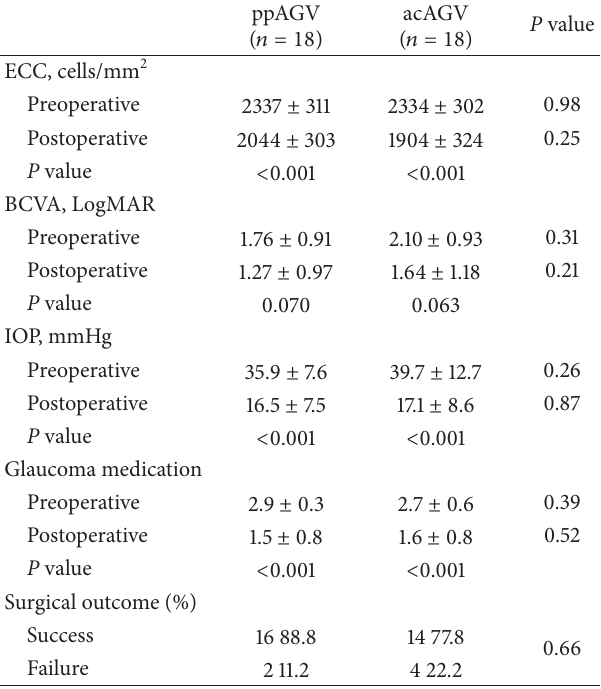
Table 2: Preoperative and postoperative 18-month values in the ppAGV and acAGV groups.